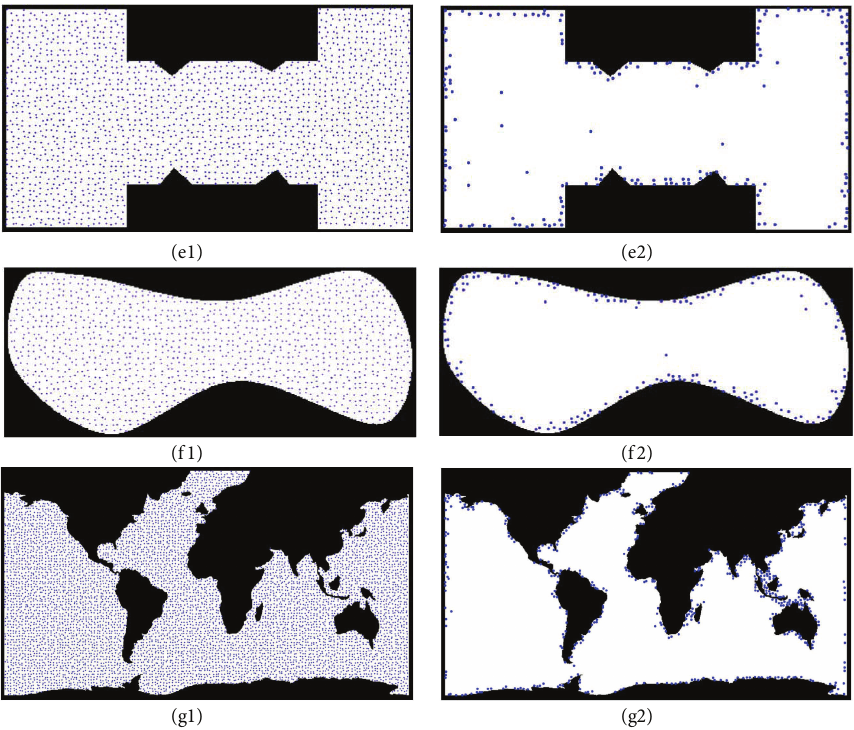
Figure 9: Boundary recognition in multiple cases. (a) 3023 nodes with average degree 13.1; (b) 2094 nodes with average degree 12.6; (c) 2381 nodes with average degree 13.0; (d) 2115 nodes with average degree 12.5; (e) 2024 nodes with average degree 13.4; (f) 1311 nodes with average degree 13.2; (g) 6811 nodes with average degree 13.3.